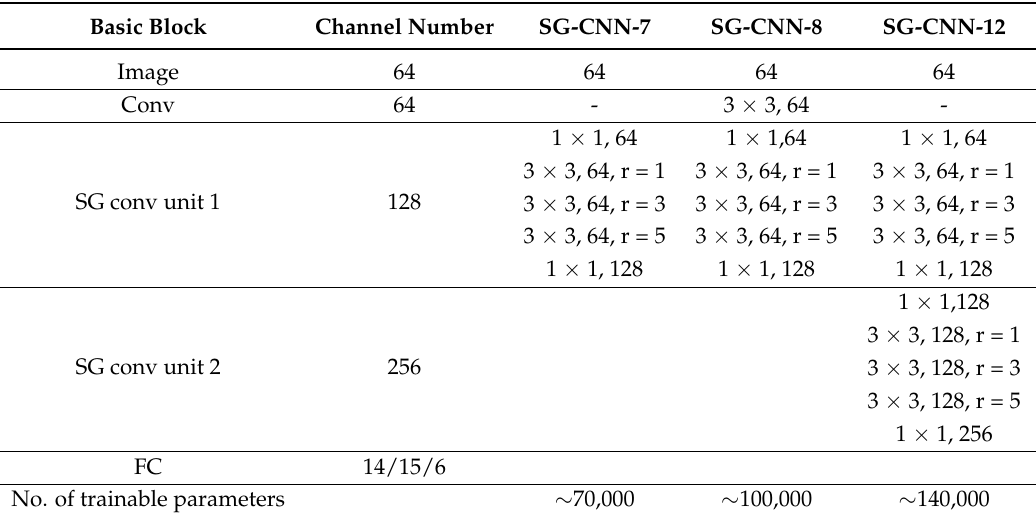
Table 2. Overall SG-CNN architecture with different levels of